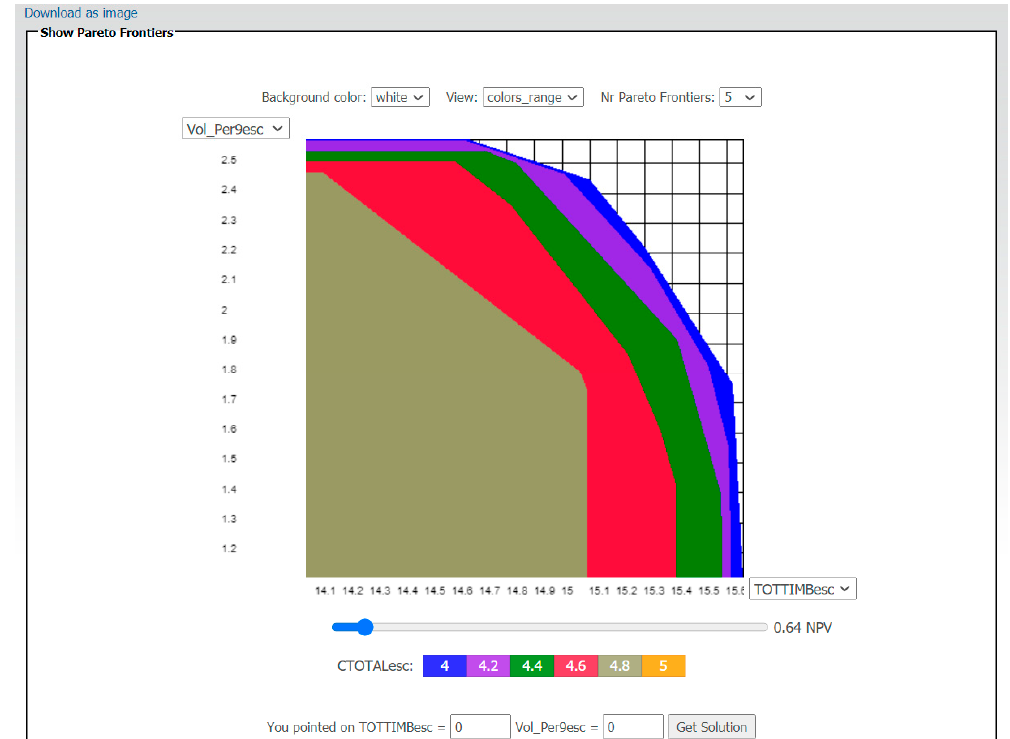
Figure 9. Interactive decision map showing the tradeoff between four criteria: volume of ending inventory (10 6 m 3 ; Vol_Per9esc) in the y -axis; total wood (10 6 m 3 ; TOTTIMBesc) in the x -axis; the average carbon sequestered (Mg year − 1 ; CTO- TALesc) in the colored scale and the chosen level of net present value level (10 8 EUR; NPV) in the slider (0.64 10 8 EUR).